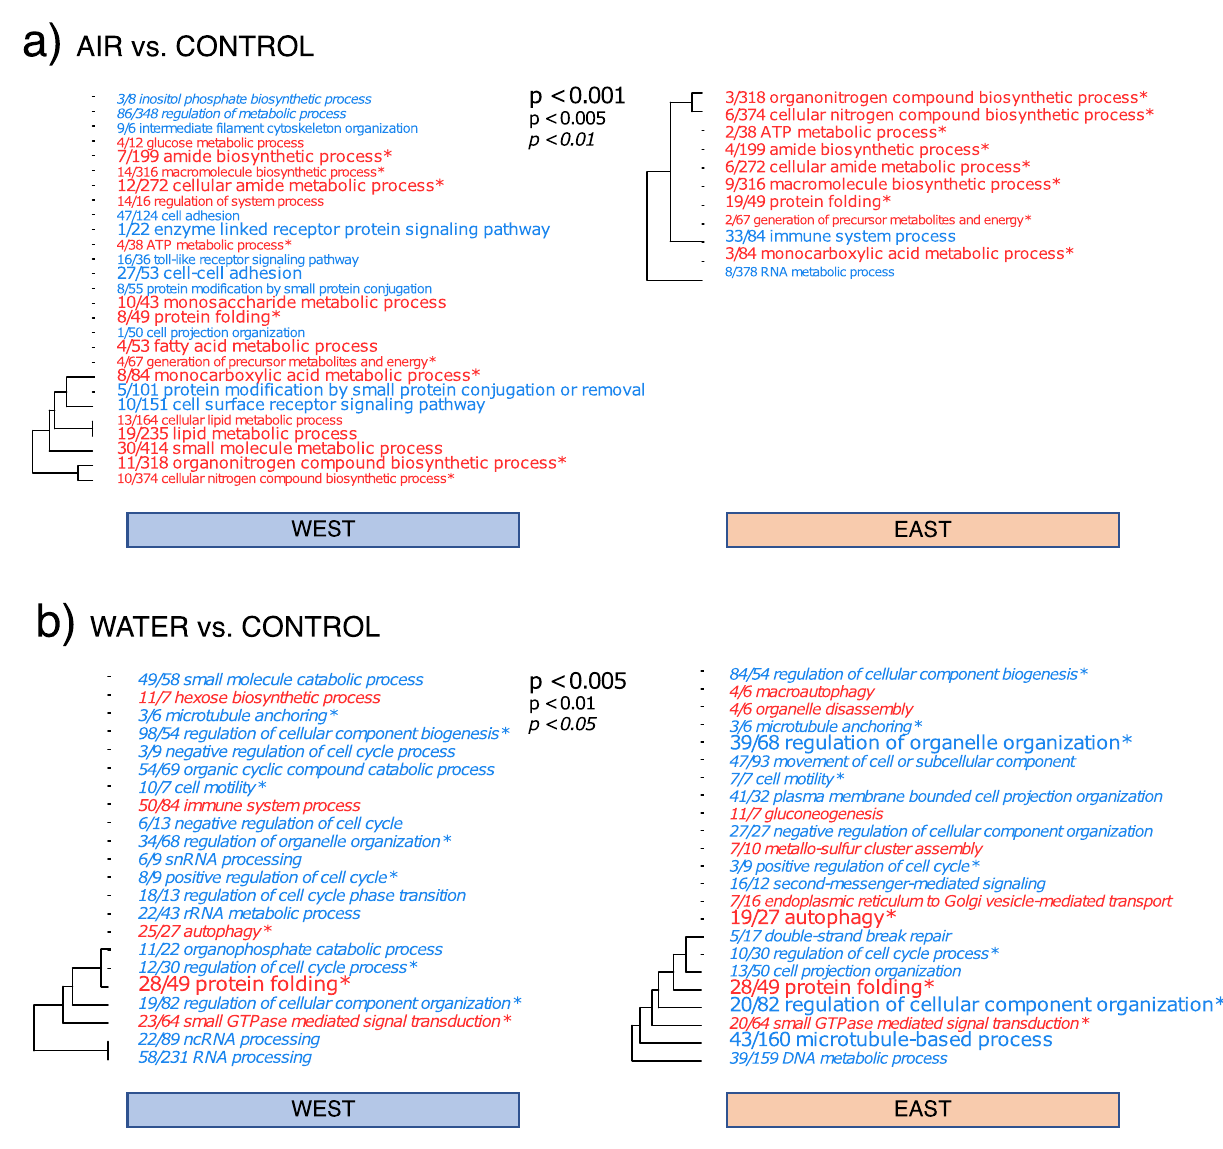
Figure 6. Gene ontology (GO) enrichment analysis in the Biological process category in response to ( a ) AIR and ( b ) WATER versus the respective controls for the Western and Eastern lineages (left and right panels, respectively). Up-regulated GO terms are shown in red and down-regulated in blue. Size and style of the text corresponds to the significance level (Mann–Whitney U-tests on ranked genes) shown in the legends. Hierarchical clustering trees indicate gene sharing between GO categories; zero-length branches are subsets of each other. The fractions preceding GO terms indicate the numbers of annotated genes passing/failing an unadjusted P value threshold of 0.05. Asterisks (*) depicts common GO terms between